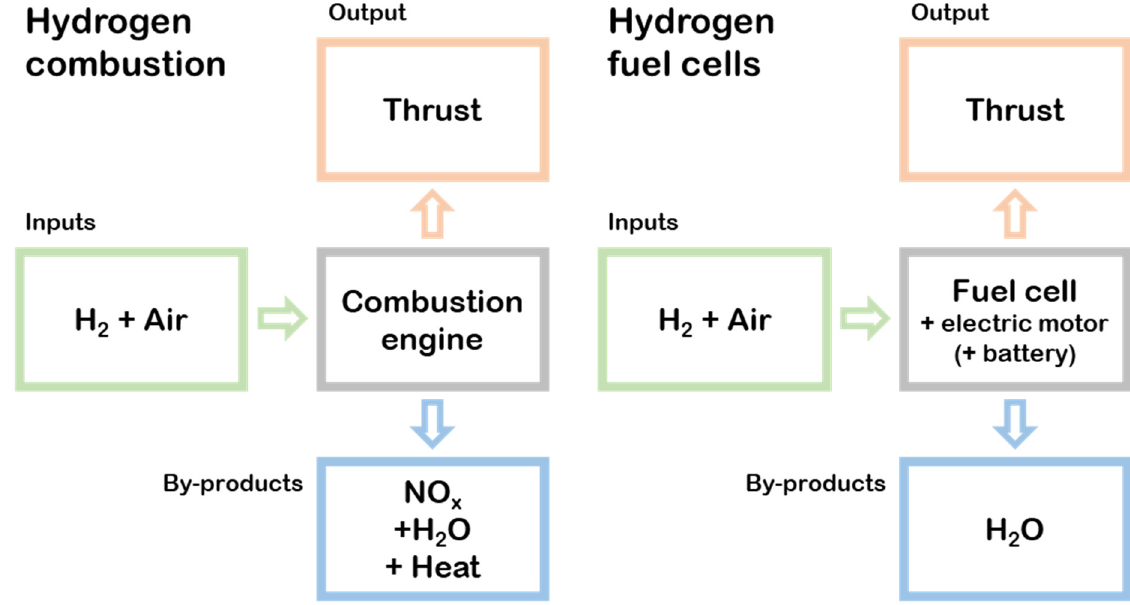
Figure 2. Propulsion system using hydrogen